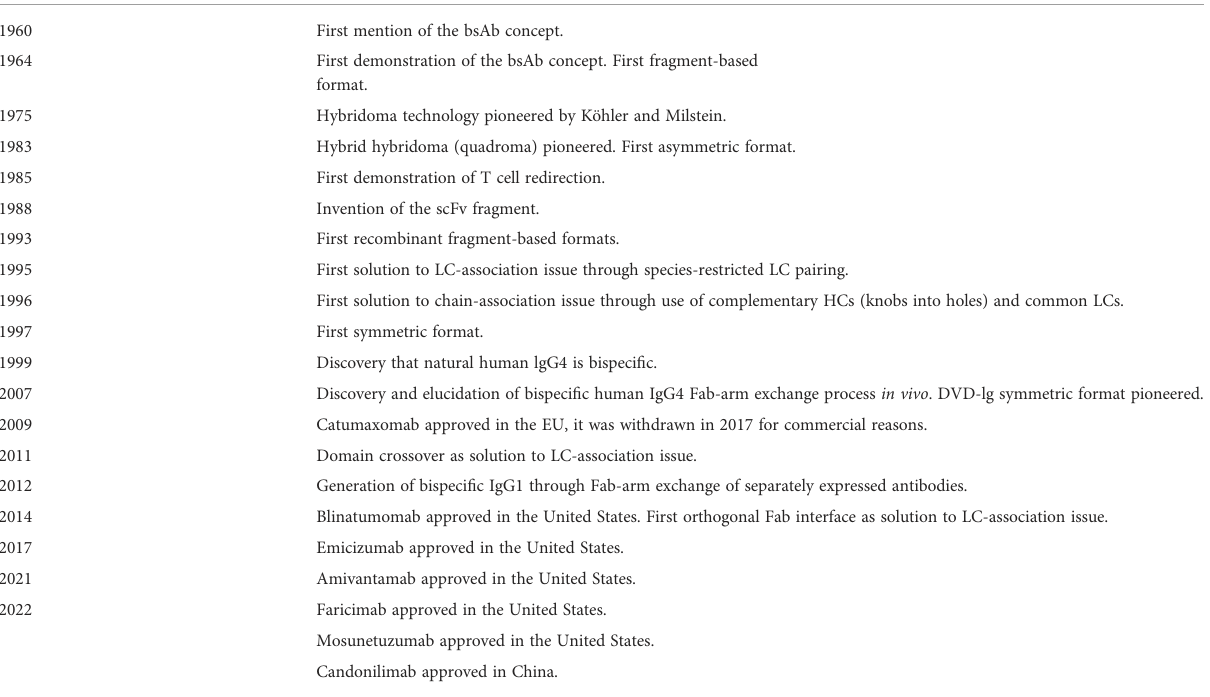
TABLE 1 Timeline of bsAb